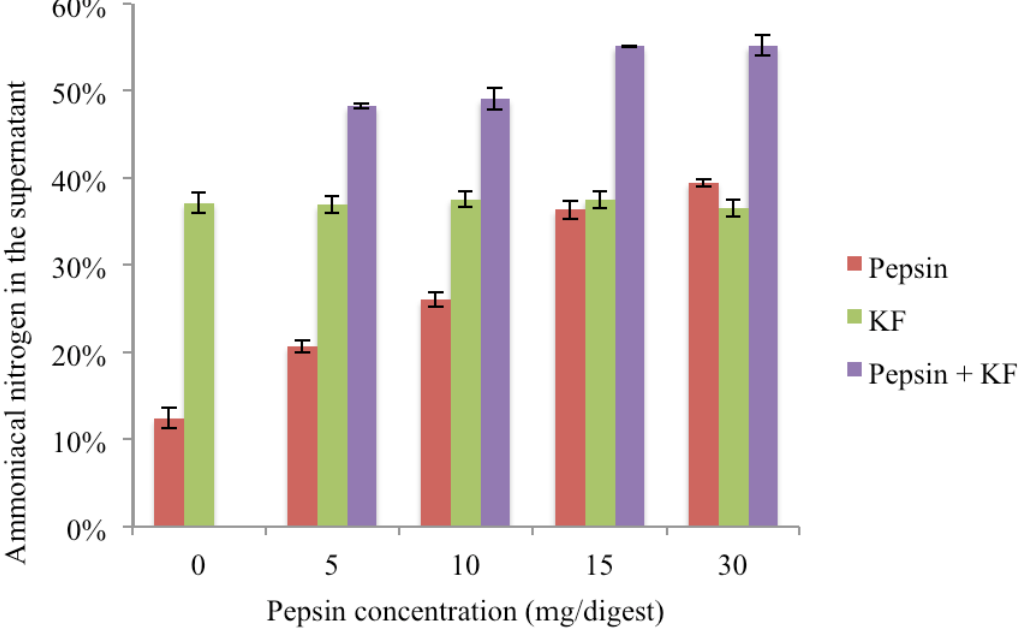
Figure 4. Effect on the hydrolysis of 600 mg of freeze-dried meat (FDM) after 60 min primary digestion with pepsin alone (red bars), or in combination with 100 mg of KF (purple bars). The green bars indicate the hydrolysis effect in 0.022 M HCl of 100 mg of KF on 600 mg of FDM in the absence of pepsin. Incubations each contained 20 mL 0.022 M HCl, 600 mg of FDM, plus various combinations of pepsin ranging from 0 to 30 mg/digest alone or in combination with 100 mg KF. Bars are means of duplicates and errors are standard deviations